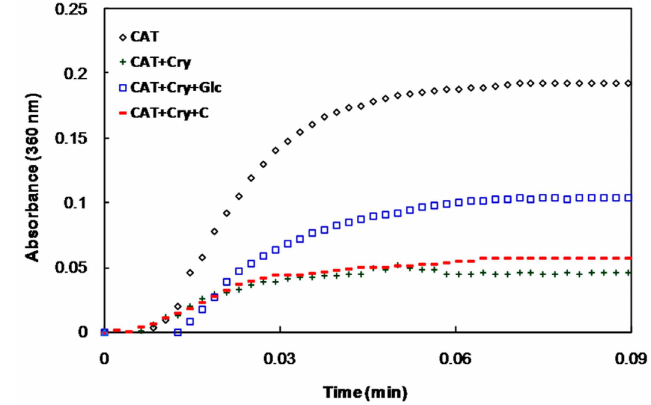
Figure 4. Chaperone activity of α -crystallin as measured by the suppression of heat-induced aggregation of catalase. Catalase was incubated at 60 ˝ C in the absence and presence of native α -crystallin and in the presence of α -crystallin with glucose or glucose+crocin(s).